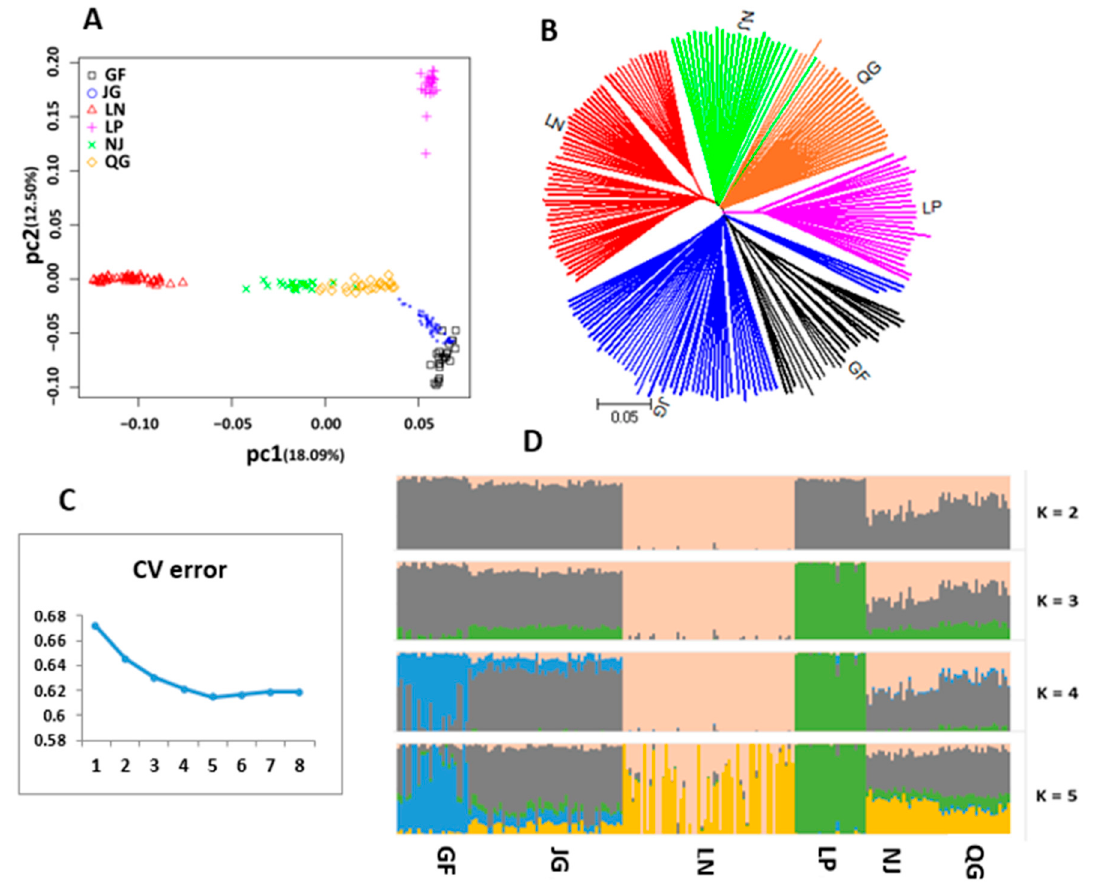
Figure 11. Phylogenetic relationships of six goat populations. ( A ) Principal component analysis of 204 individuals. ( B ) Neighbor-joining phylogenetic tree of goat breeds. ( C ) Cross-validation of six goat populations. ( D ) Genome-wide admixtures inferred by ADMIXTURE